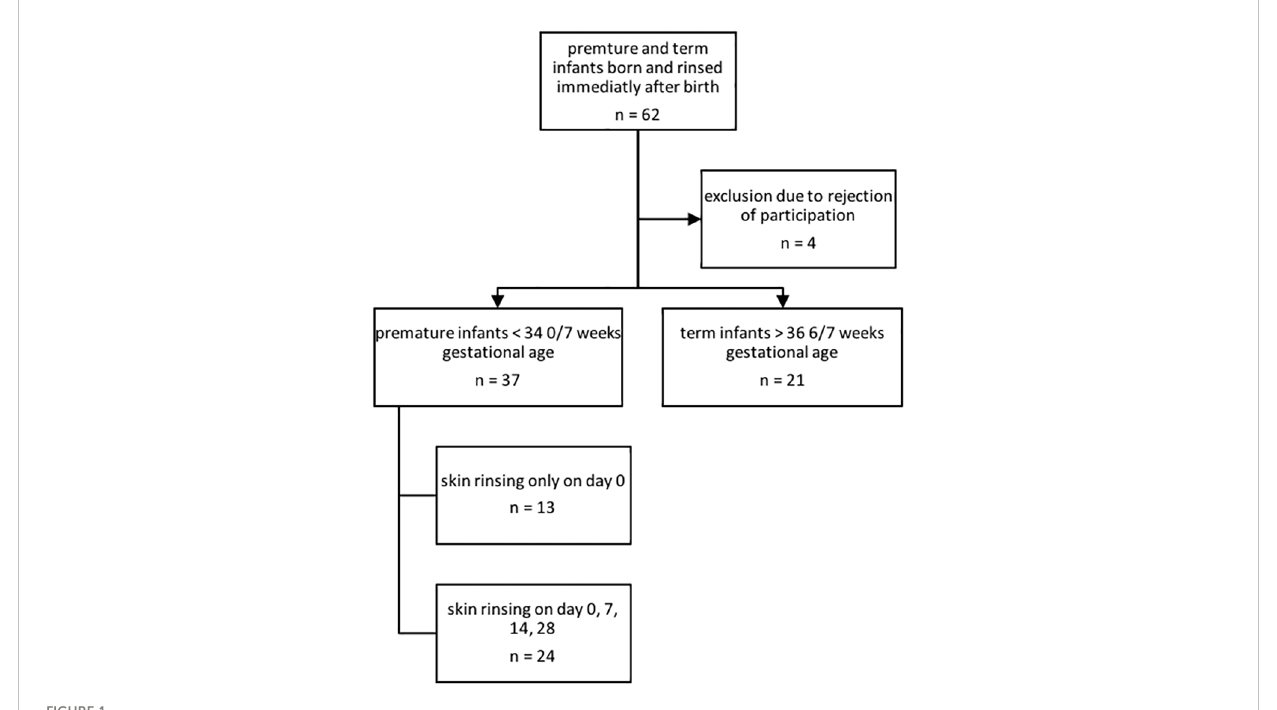
FIGURE 1 Inclusion and exclusion of premature and term infants for AMP characterization.